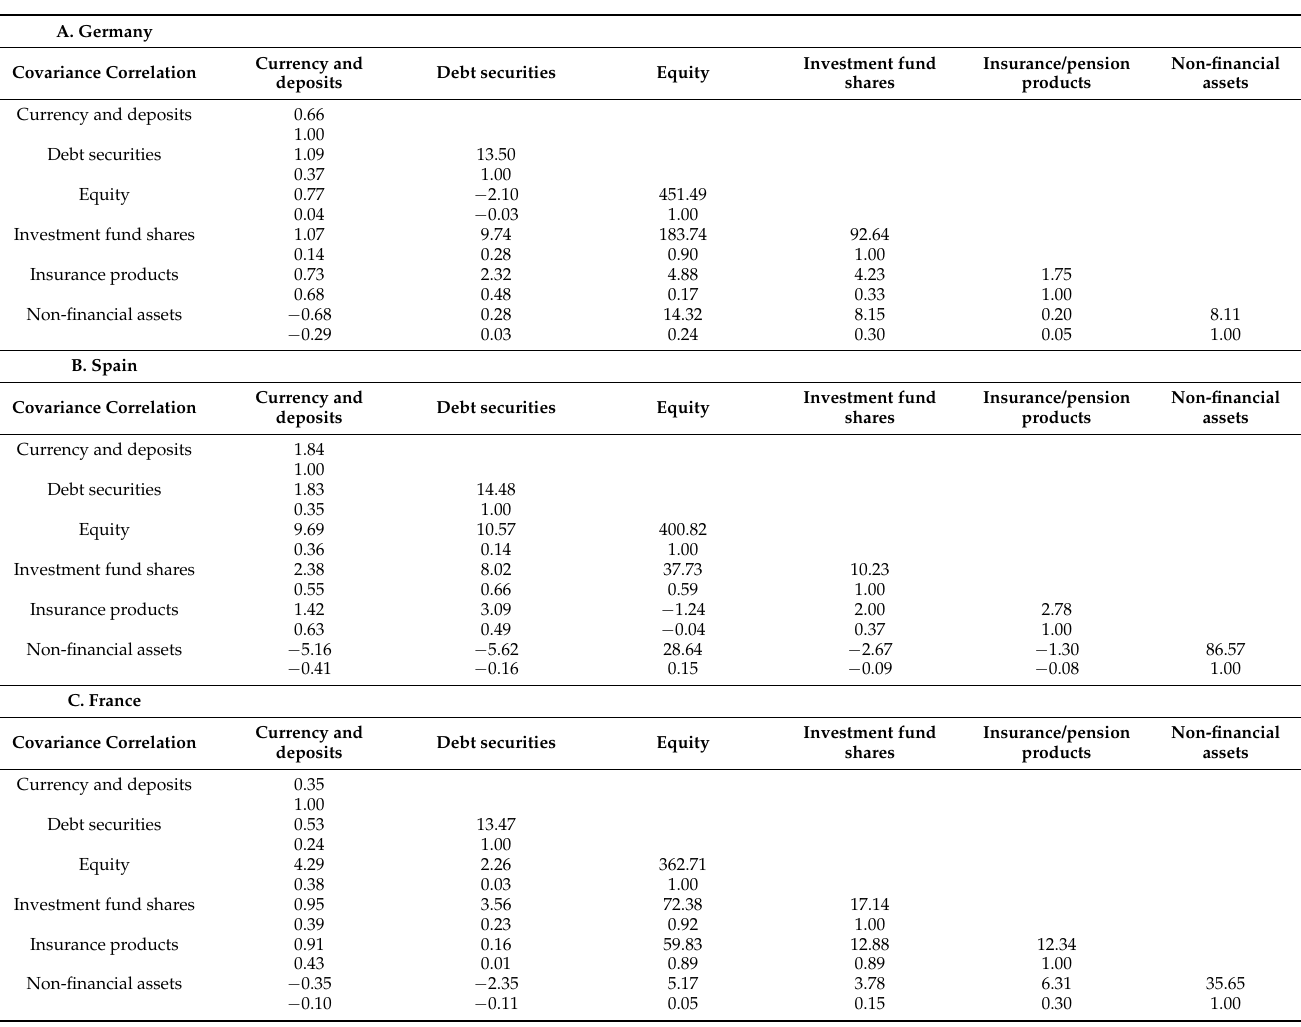
Table 3. Variance-covariance matrices and